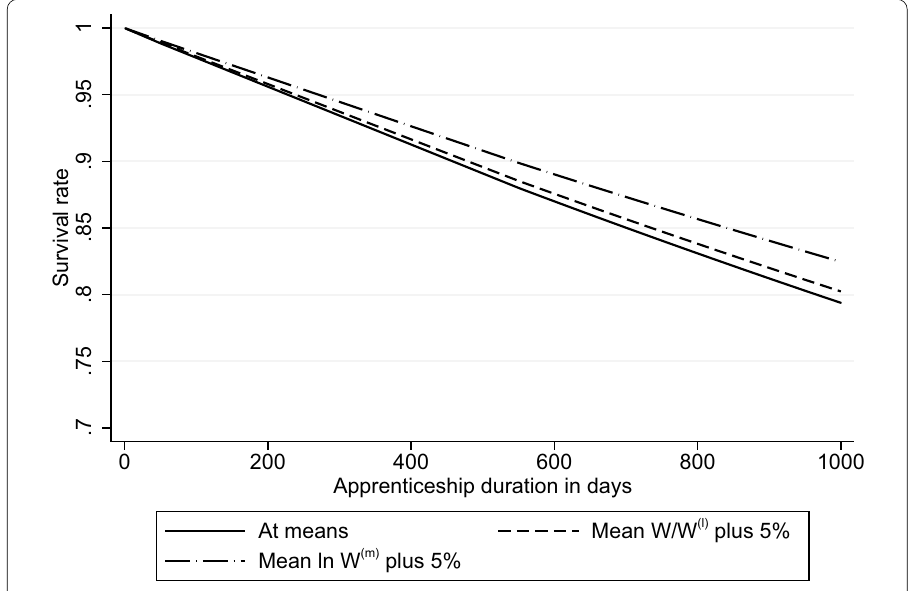
Fig. 3 Estimated survival function at different wage levels (Note: Estimation of the survival function of the model in Table 3, column 3 at means of all variables (at means), a 5% above average apprenticeship wage relative to unskilled worker wage (mean W / W ( l ) plus 5%), and a 5% above average natural logarithm of daily skilled worker wages (mean ln W ( m ) plus 5%); N 94,223 apprenticeships with 19,697 incidences of =